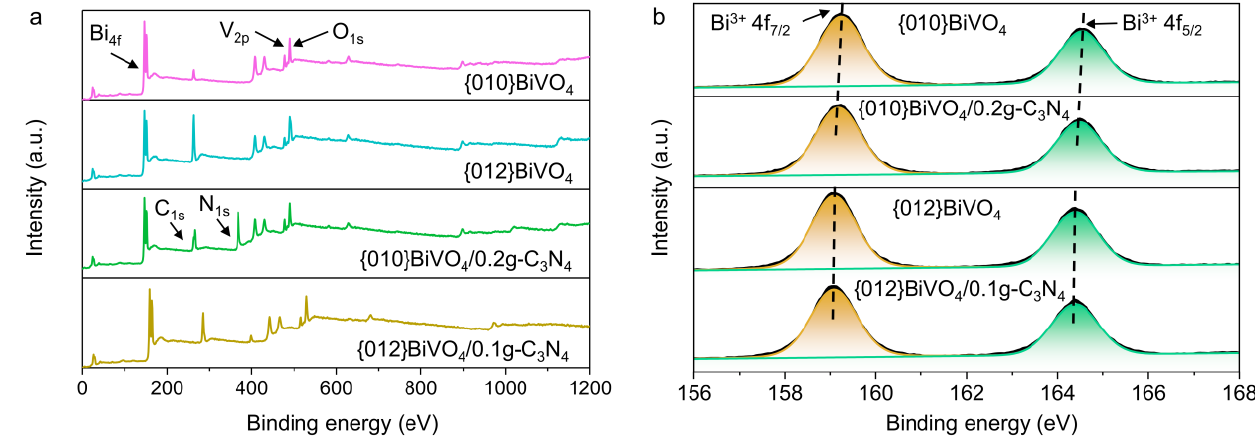
Figure 3. ( a ) Survey XPS spectra and ( b ) high-resolution XPS spectra of Bi 4f on {010}BiVO 4 , {010}BiVO 4 /0.2g-C 3 N 4 , {012}BiVO 4 , and {012}BiVO 4 /0.1g-C 3 N 4 . {010}BiVO 4 /0.2g-C 3 N 4 , {012}BiVO 4 , and {012}BiVO 4 /0.1g-C 3 N 4